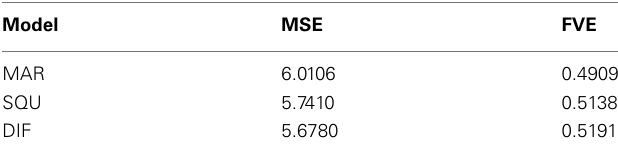
Table 4 | Comparison of the goodness-of-fit in terms of the mean squared error (MSE) and fraction of variance explained (FVE) of the fitted model predictions ˆ Y (cid:96) ( n )